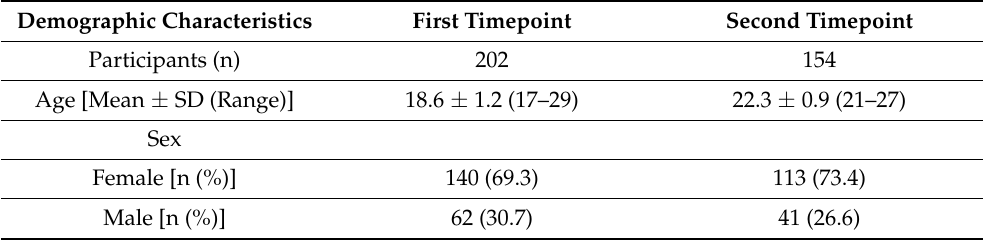
Abbreviations: SD, Standard